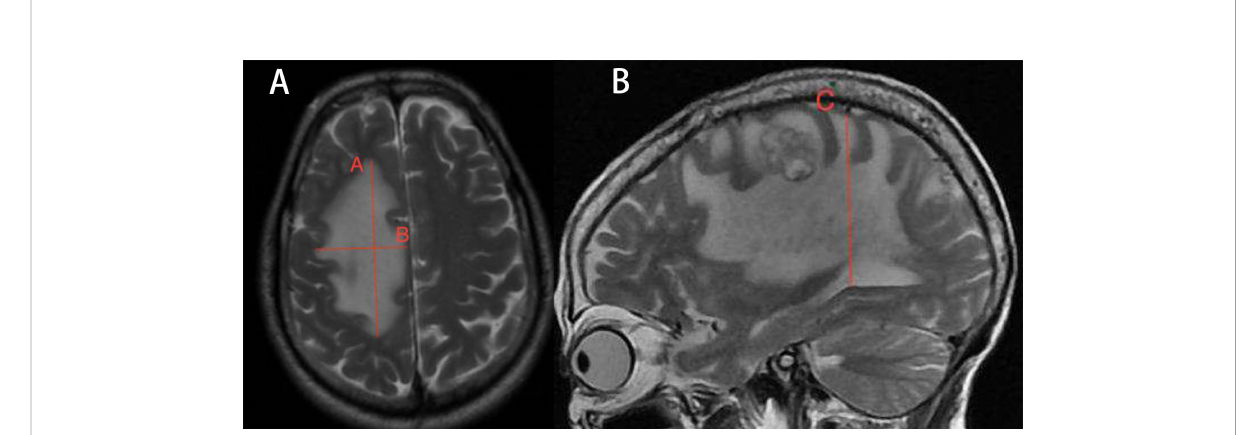
FIGURE 1 Demonstration of volume calculation technology. Volume calculation formula: V = p /6 × ABC. Volume is measured by drawing the mutually perpendicular diameters (A, B) of the largest cross-section of cerebral edema in the axial plane and maximum height of sagittal cerebral edema (C) . These measurements are substituted into the formula above to complete the volume